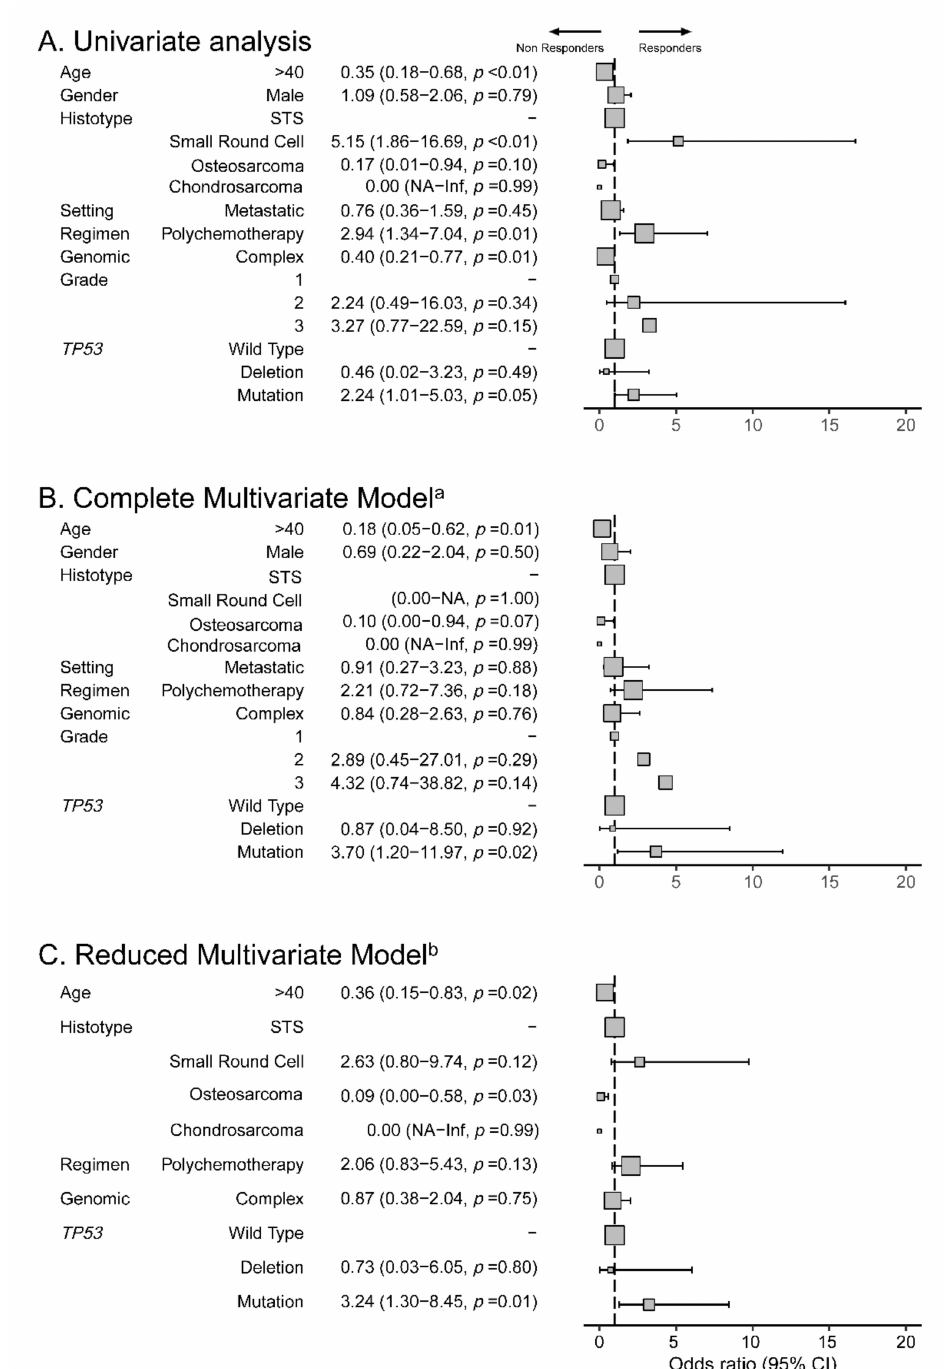
Figure 2. Predictive response to anthracyclines: factors associated with objective response rate to anthracyclines in MOSCATO and ProfiLER ( n = 161) in binomial logistic regression. ( A ): forest plot of Odds ratio (OR), in univariate analysis; ( B ): forest plot of OR in complete multivariate model a ; ( C ): forest plot of OR in reduced multivariate model b . OR = odds ratio; 95% CI = 95% confidence interval. a Complete model included: age, gender, histotype (small round cell tumors, chondrosarcomas, osteosarcomas versus soft-tissue sarcomas), setting of prescription (metastatic versus neoadjuvant), regimen (combination therapy or monotherapy), genomic (complex versus simple) and TP53 alterations. b Reduced model included only variable with p < 0.05 in univariate model: age, regimen (combination therapy or monotherapy), genomic (complex versus simple) and TP53